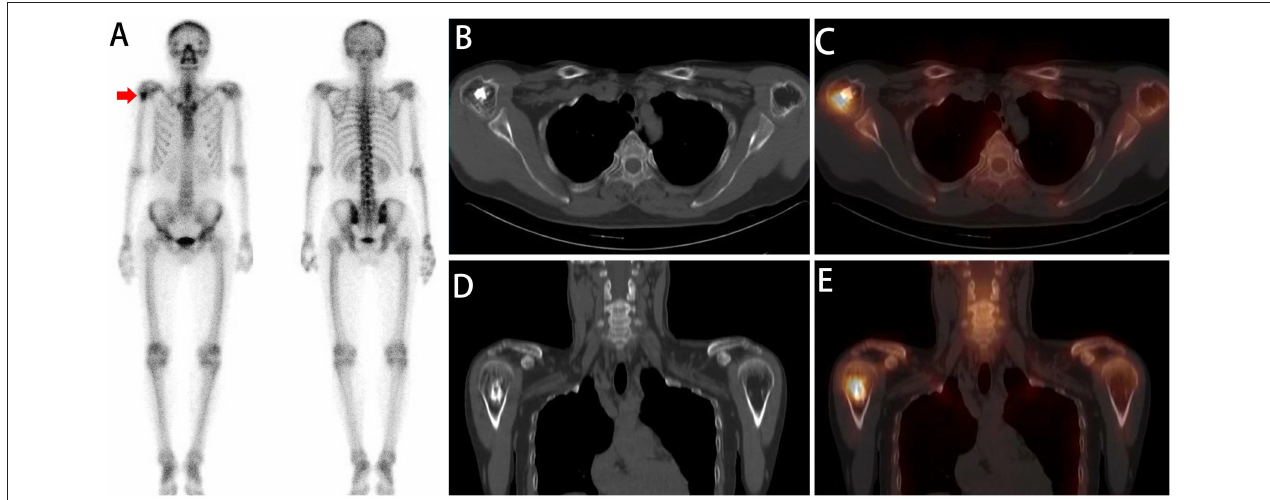
FIGURE 3 | A whole-body scan (A) revealed a focal area of high 99m Tc-MDP activity in the right humerus (red arrow). No additional areas of abnormal 99m Tc-MDP uptake were identified in the remainder of the skeleton. Axial (B,C) and coronal (D,E) CT and SPECT/CT imaging showed focally increased 99m Tc-MDP uptake corresponding to ossification in the proximal part of the humerus. The diagnosis of enchondromas was established by a combined assessment of clinical and radiologic